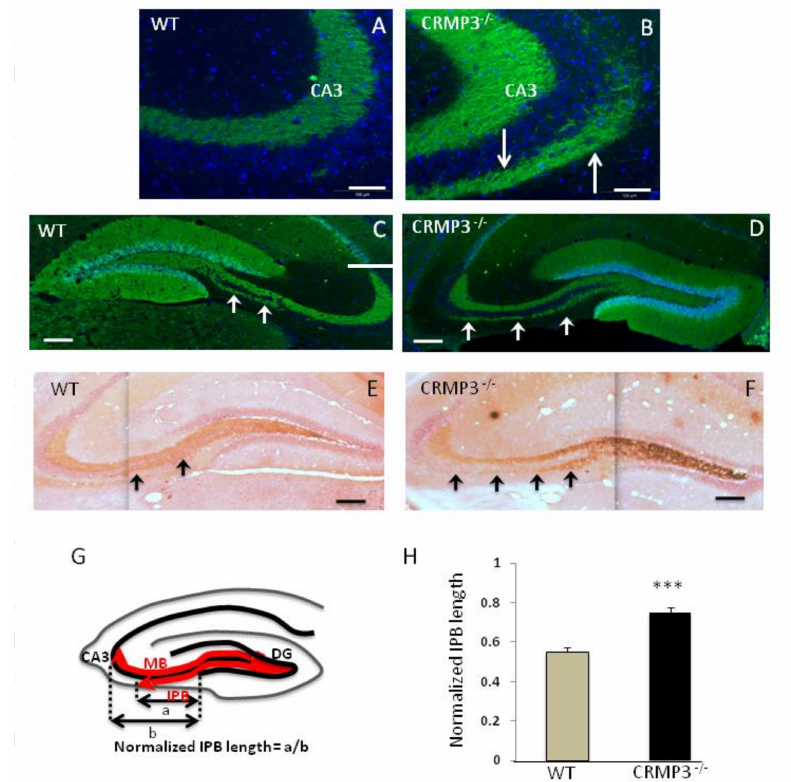
Figure 3. Altered infrapyramidal bundle (IPB) in CRMP3 − / − mice. ( A – F ): Free-floating coronal ( A , B ) and sagittal ( C – F ) hippocampal sections (20 µ m) from 2.5 month old mice ( n = 5 for each genotype) immunostained with antibodies to calbindin (green) and DAPI (blue) ( A – D ) or with sulfide silver ( E , F ) from WT ( A , C , E ) or CRMP3 − / − ( B , D , F ) mice. In WT, the IPB stops before the beginning of the CA3 curvature ( A ) white arrows; and ( C ) black arrows, whereas it extends clearly beyond it in CRMP3 − / − mice ( D ), white arrows; and ( F ) black arrows. ( G ) Schematic drawing of mossy fibers (MF) showing their dentate origin and their characteristic trajectories (MB: main bundle). ( H ): Quantitation and analyses of IPB length. The IPB length “a” was measured from the tip of the inferior blade of the granular layer and the length of CA3, “b” was determined from the tip of the inferior blade to the apex of the curvature of the CA3 pyramidal cell layer. Quantitation of normalized IPBs defined as a/b confirms the abnormal IPB in the mutants. Statistical significance was assessed by two-tailed t test, *** p < 0.01. Scale bar = 50 µ m in ( A , B ); 200 µ m in ( C , F ). Error bars indicate standard error of the mean